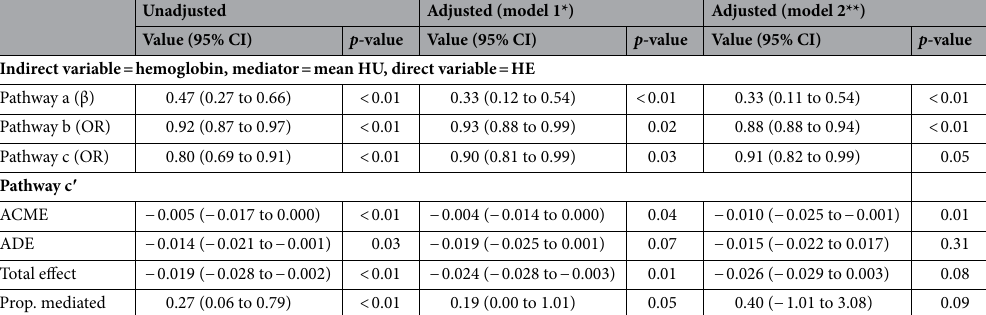
Table 2. Association among hemoglobin levels, the mean HU and HE. *Model 1: Adjusted for age, sex, time from onset to CT, history of previous antiplatelet and anticoagulant agents, and baseline hematoma volume. **Model 2: Model 1 + additionally adjusted for baseline systolic blood pressure and location of hematoma. HU, Hounsfield unit; HE, hematoma expansion; CI, confidence interval; β, coefficient; OR, odds ratio; ACME, average causal mediation effect; ADE, average direct effect; Prop. mediated, proportion